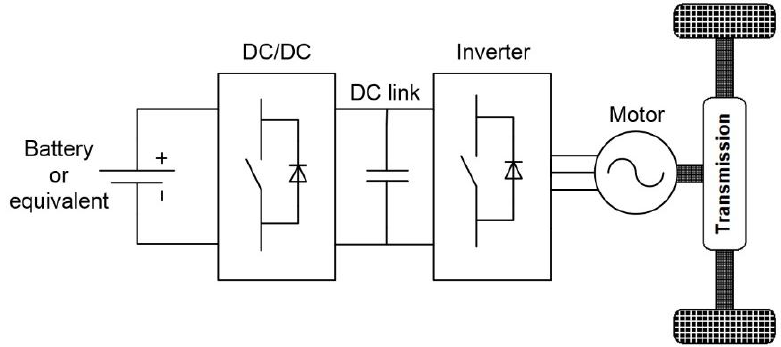
Figure 1. Powertrain topology of a battery electric vehicle used in this